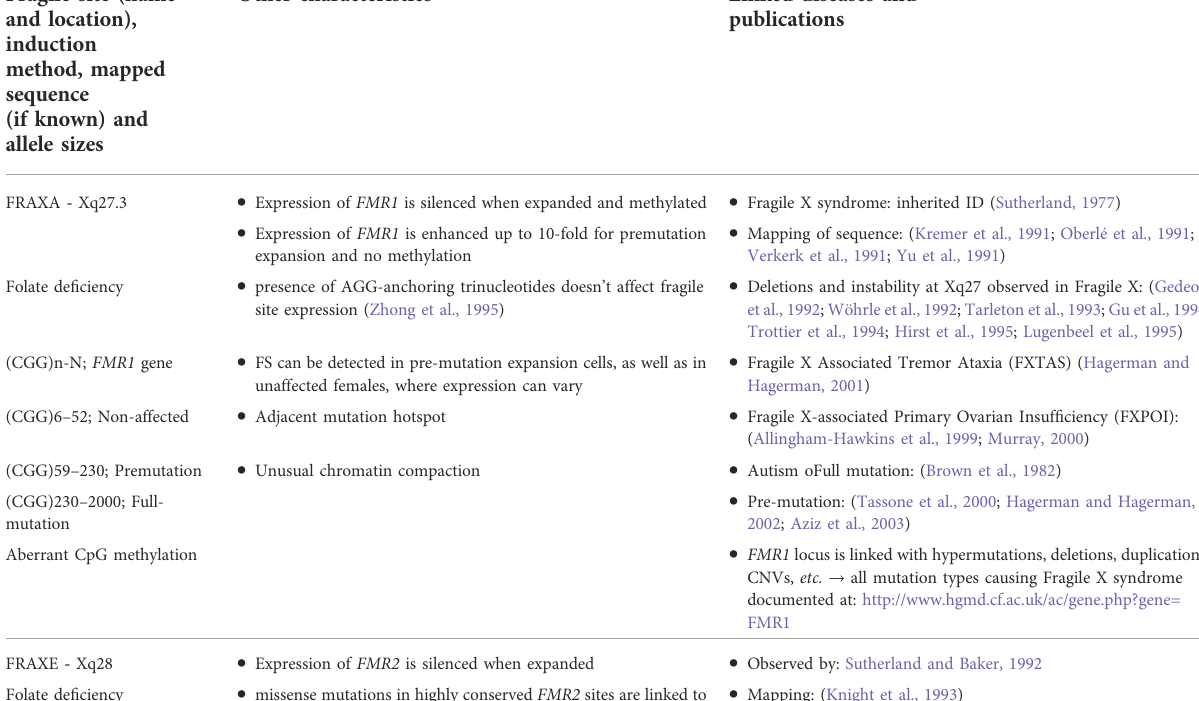
TABLE 2 Rare fragile sites (folate, distamycin A, and